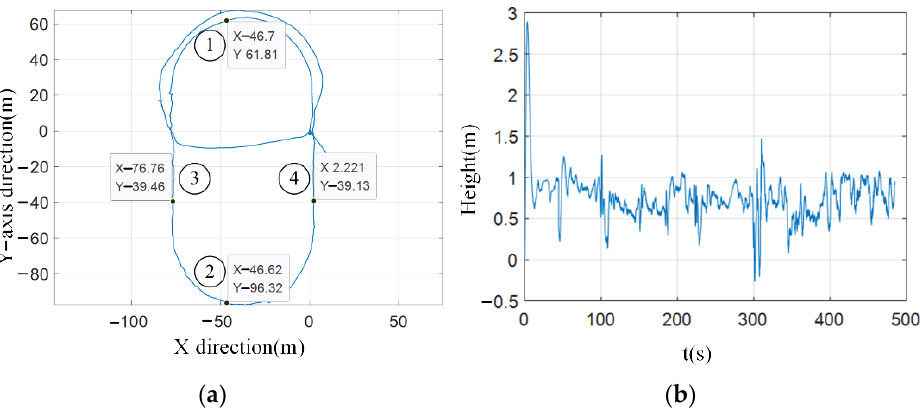
Figure 15. Plane track of detour playground and variation of height. ( a ) Plane track of detour playground. ( b ) Variation of height.